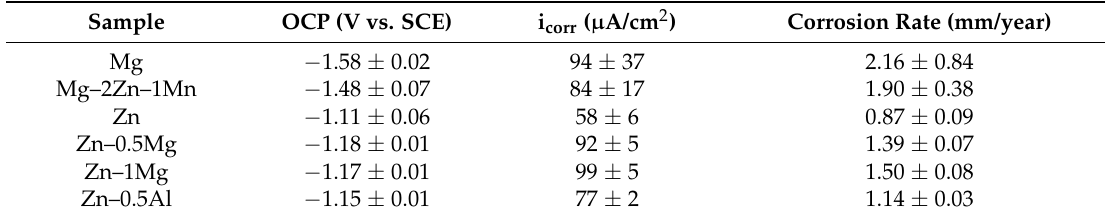
Figure 1. Typical open circuit potential (OCP) and potentiodynamic polarization (PDP) results: ( a ) potential vs. time, ( b ) potential vs. current. Table 2. Corrosion parameters derived from PDP results.